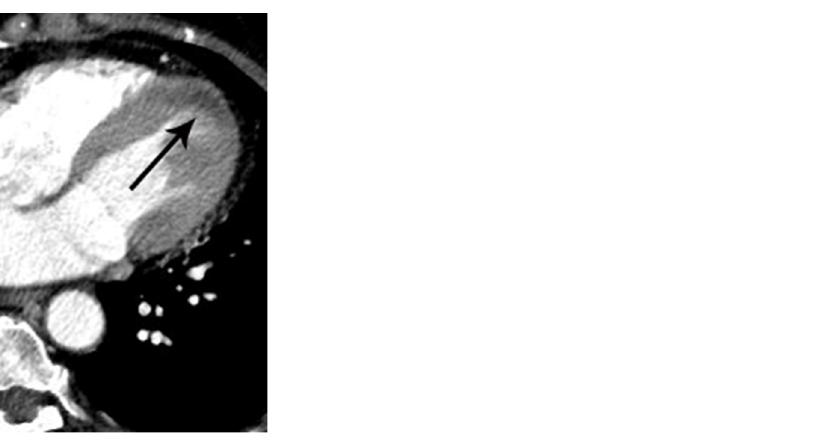
Figure 4. False negative diagnosis of acute myocardial infarction on non-gated chest CT in a 67- year-old female with a small acute myocardial infarction. ( A ) Equivocal MPD (CT score of 1 for myocardial perfusion defect (MPD)) (arrow) was noted in the basal lateral segment of the left ven- tricle on an axial image. ( B ) Subsequent coronary angiography showed total occlusion (arrow) of the posterolateral branch of the right coronary artery, suggesting a culprit lesion. Note that it was difficult to differentiate true MPD from artifacts in this case.